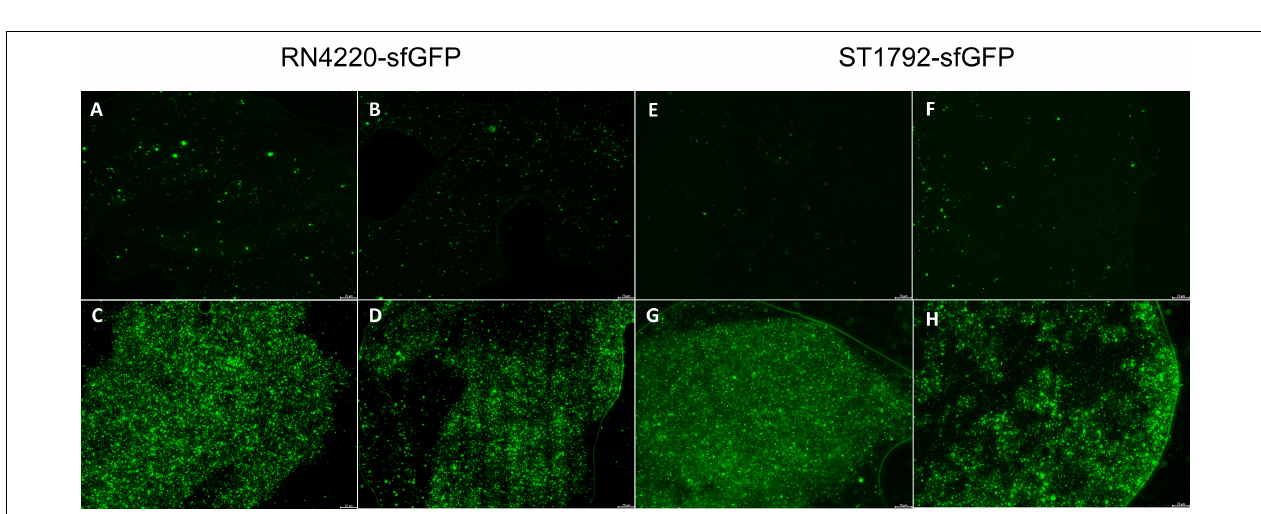
FIGURE 8 | Representative fluorescence images of biofilm in vivo . Titanium discs was harvested on seventh day since infection and observed under microscope. Green fluorescence represents sfGFP labeled RN4220 (A–D) and ST1792 (E–H) . (A,E) Mice model given SarA inhibitor ZINC00990144. (B,F) Mice model given ZINC00990144 and sub-MIC vancomycin. (C,G) Control mice model without sub-MIC vancomycin. (D,H) Mice model given sub-MIC vancomycin. Scale bar = 75 µ m.